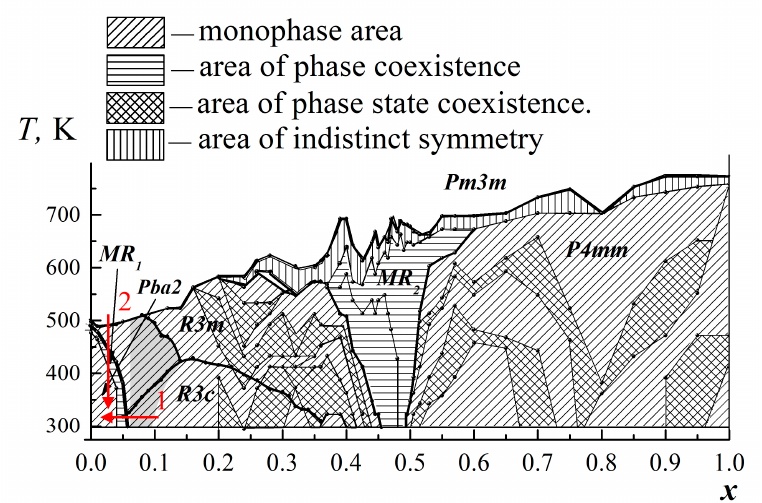
Figure 6. x - T phase diagram of the PZT system SS samples (Adapted with permission from Ref. [15]. This article was published in “Ceramics International”, 39, Andryushina, I.; Reznichenko, L.; Shilkina, L.; Andryushin, K.; Dudkina, S., The PZT System (PbTi x Zr 1 − X O 3 , 0 ≤ X ≤ 1.0): High Temperature X-Ray Diffraction Studies. Complete X-T Phase Diagram of Real Solid Solutions (Part 3), Page No 2889–2901, Copyright Elsevier (2013)). MR1 and MR2 are morphotropic regions. Arrow 1 shows the ferro-antiferroelectric phase transition in concentration; arrow 2 shows the ferro-antiferroelectric phase transition in